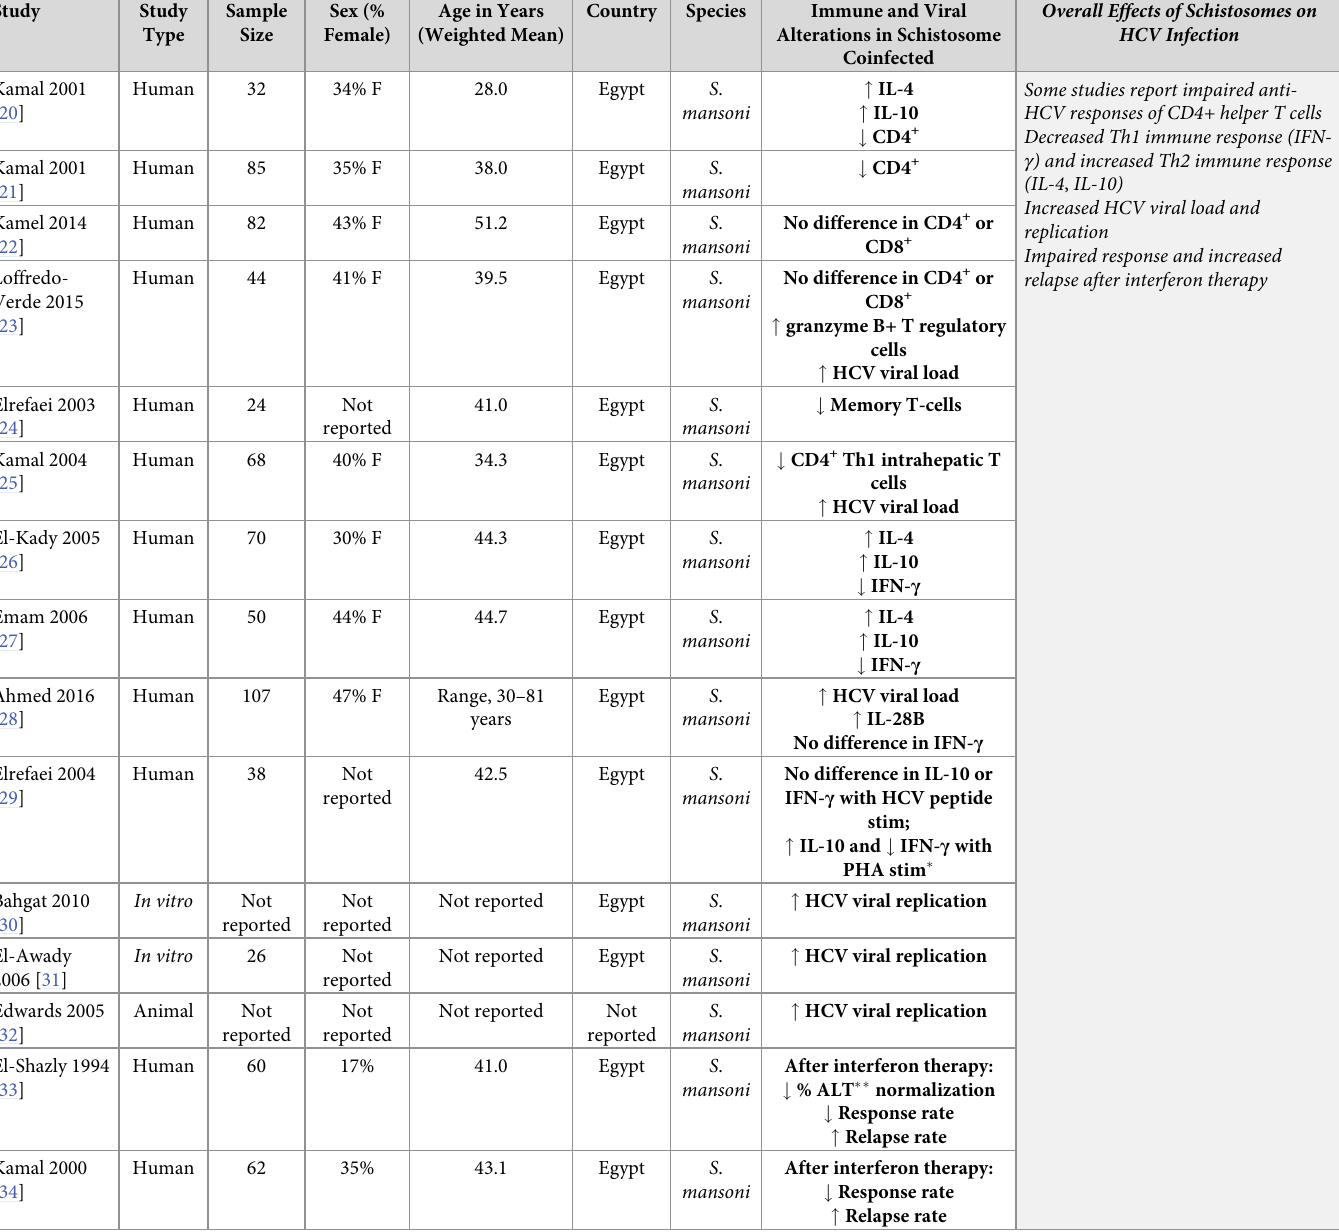
Table 1. Effects of Schistosome Coinfection on the Host Immune Response to Hepatitis C Virus.